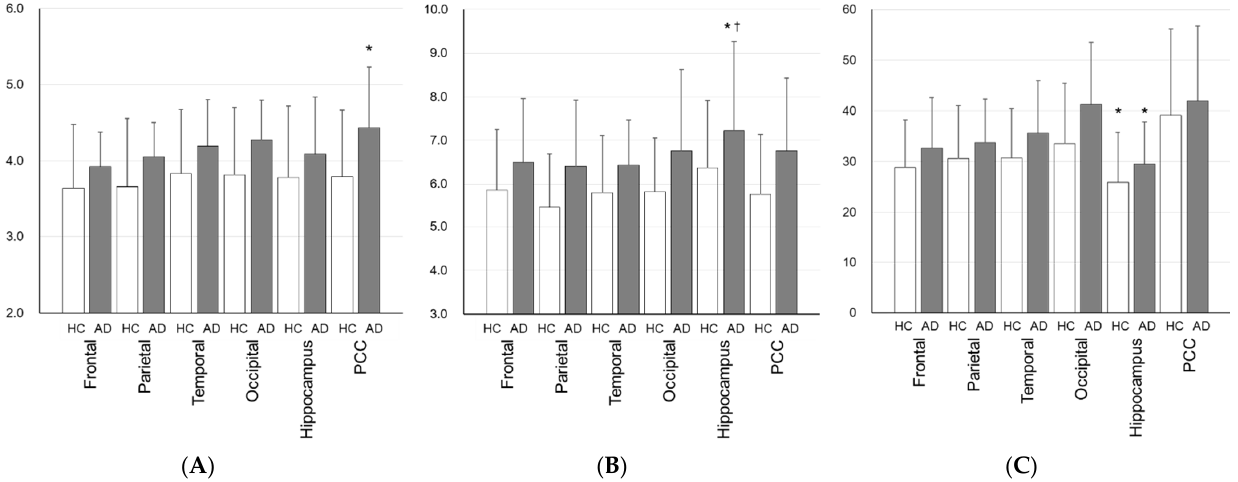
HC—healthy control; eAD—patients with early Alzheimer’s disease; SUV—standardized uptake value; PCC—posterior cingulate cortex. † p < 0.05 compared with frontal and parietal lobes of HCs. * p < 0.05 compared with all lobes and PCC of HCs.